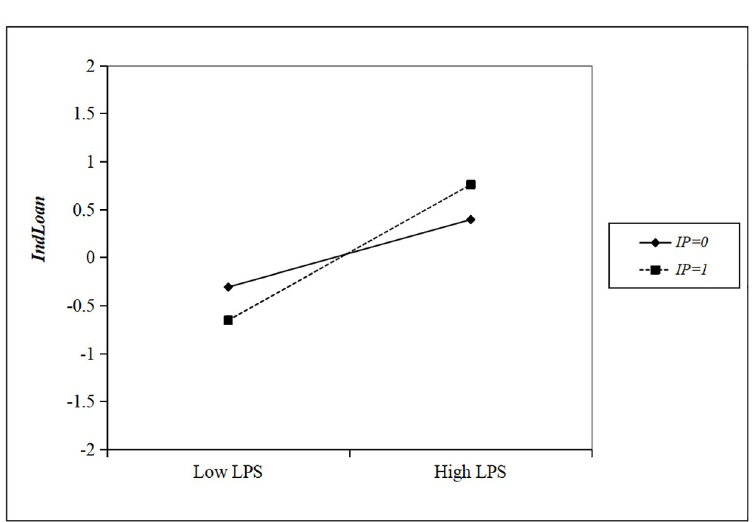
Fig 3. Moderating effect of local industrial policies on the large private shareholders—Industry loans of city commercial banks relationship.